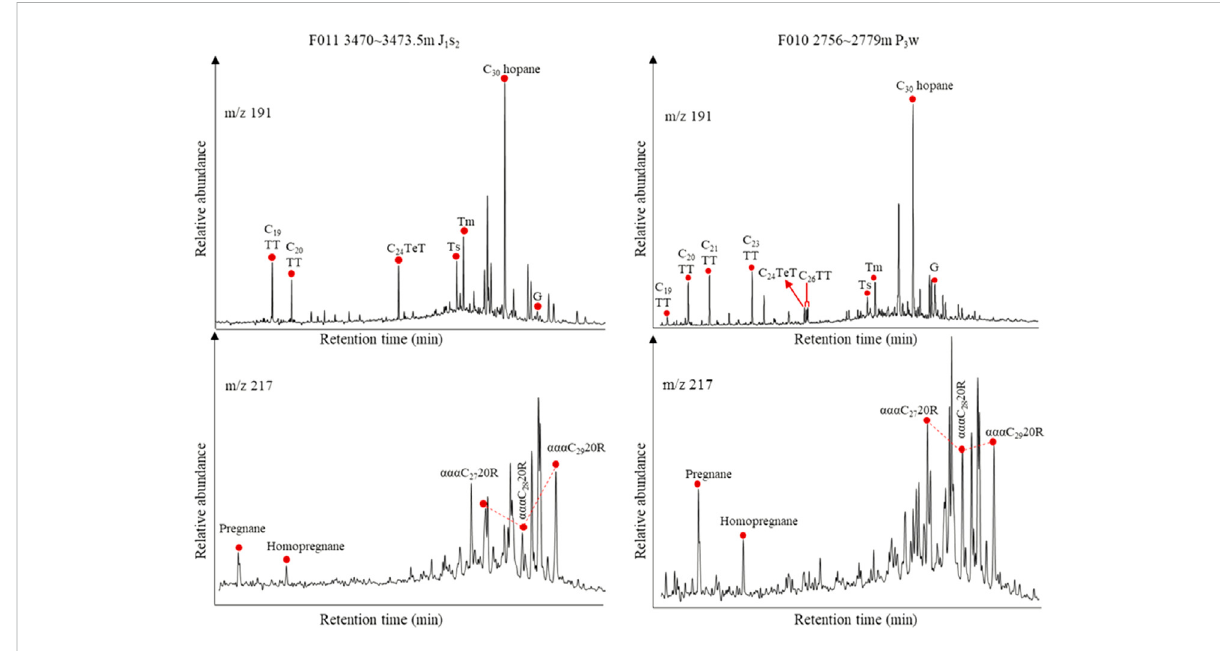
FIGURE 3 Typical biomarker chromatograms of saturated hydrocarbons in crude oil in the East Fukang Sag. m/z 191= terpanes, m/z 217=steranes,